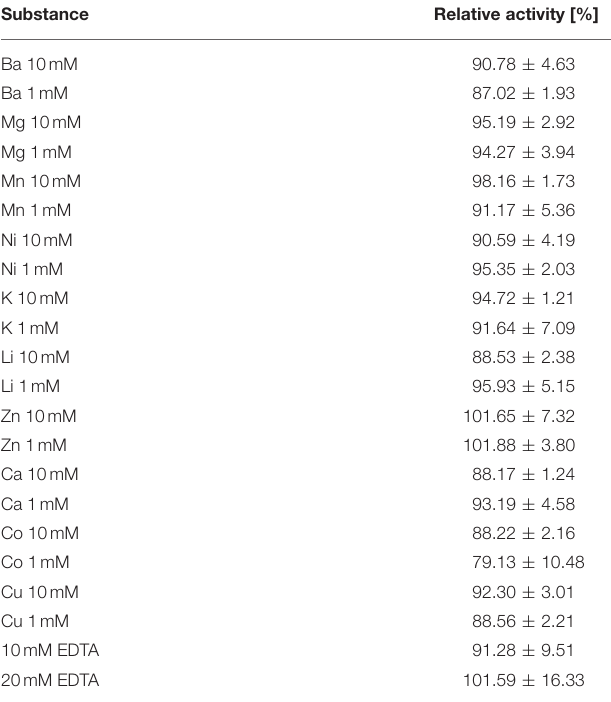
TABLE 1 | Relative activity of Xyl43Nc toward 4-nitrophenol-xylopyranoside after addition of different ion concentrations or EDTA compared to the reaction without